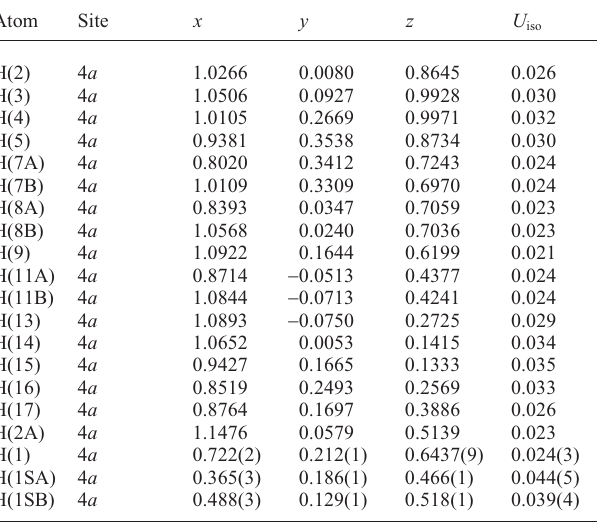
Table 2. Atomic coordinates and displacement parameters (in Å 2 )